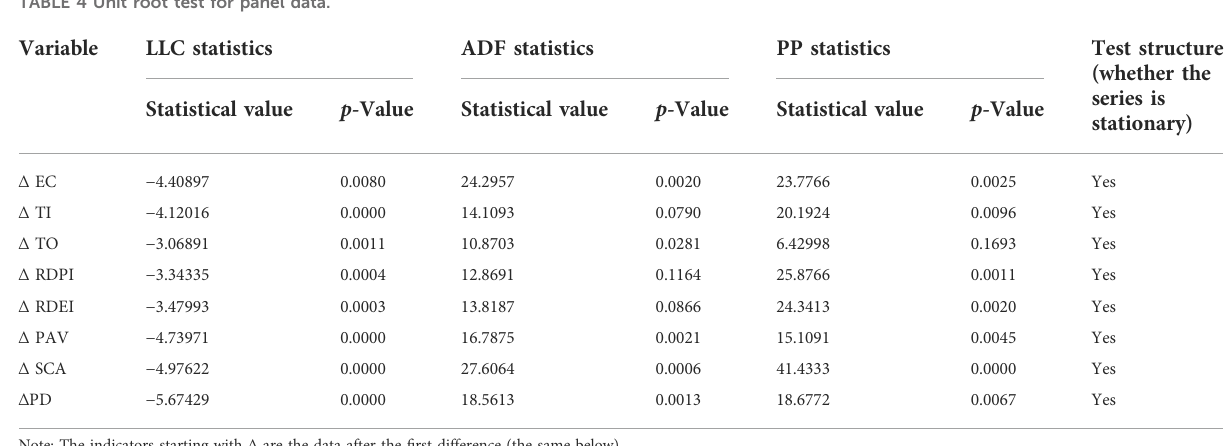
TABLE 4 Unit root test for panel data.